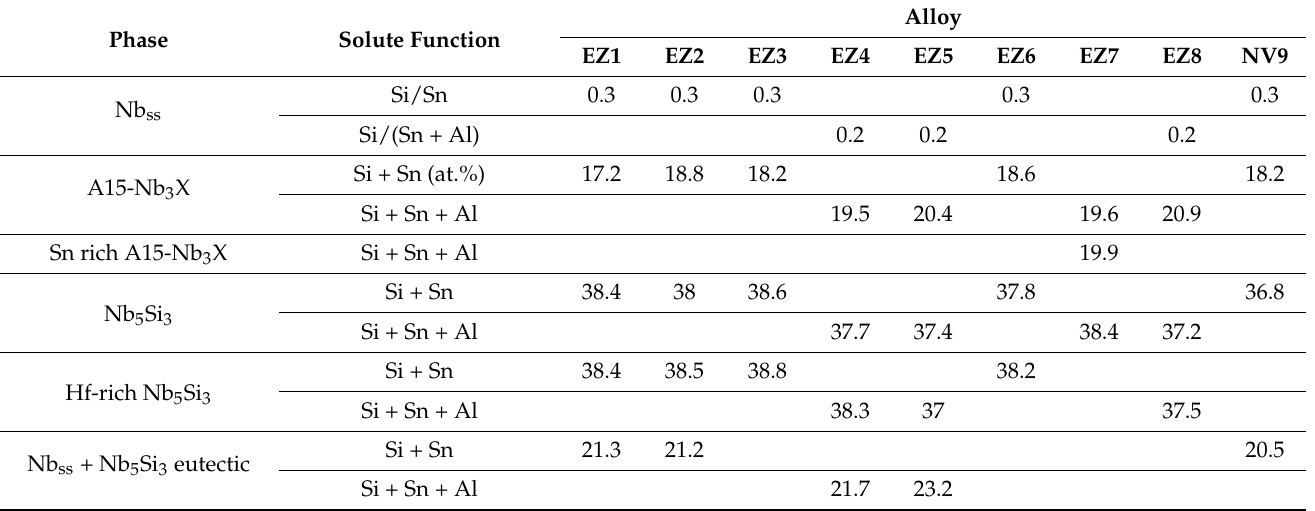
Table 8. Comparison of compositions (at.%) of Nb ss , A15-Nb 3 X, Sn-rich A15-Nb 3 X, Nb 5 Si 3 , and Hf-rich Nb 5 Si 3 in different as-cast Nb silicide-based alloys. For alloy nominal compositions